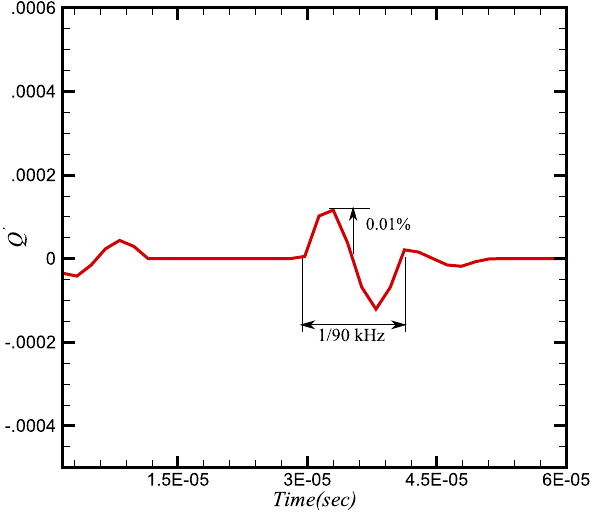
Figure 9. Relative change in the burning velocities at different amplitudes and a constant frequency of 5